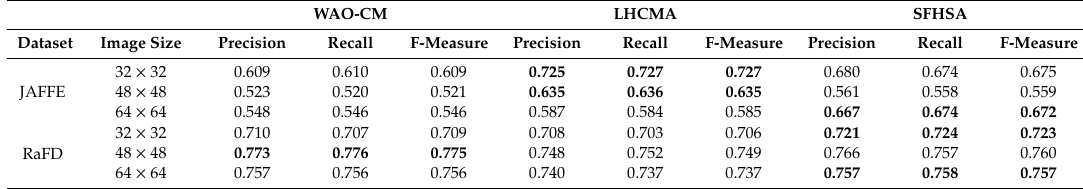
Table 9. Performance of SFHSA with respect to WAO-CM and LHCMA for hvnLBP features in terms of Precision, Recall and F-measure.